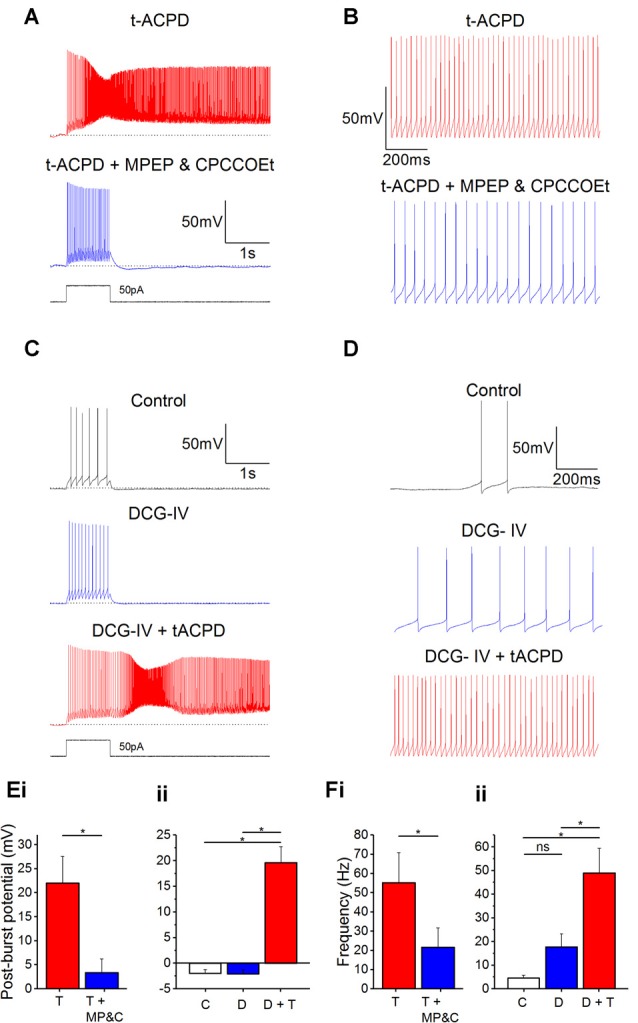
Plateau potentials are evoked by group I but not group II mGluR activation. (A) Typical response to 50 pA 1 s current pulse in the presence of 15 μM tACPD, before and after application of the mGlu5R antagonist MPEP and the mGlu1R antagonist CPCCOEt. (B) Example traces showing the decrease in spontaneous firing in the presence of t-ACPD following addition of MPEP and CPCCOEt. (C) Example traces of plateau potentials following application of the selective Group II mGluR agonist DCG-IV and DCG-IV and tACPD. (D) Example traces of spontaneous firing following application of DCG-IV and DCG-IV and tACPD. (E) Summary plots of the post-pulse potential in the presence of t-ACPD following the addition of MPEP and CPCCOEt (i; n = 5) and following DCG-IV application and subsequence tACPD application (ii; n = 5). (F) Summary plots of spontaneous firing frequency in the presence of tACPD following the application of MPEP and CPCCOEt (i; n = 4), and in response to DCG-IV and following sequential application of tACPD (ii; n = 5). Error bars = SEM. *P < 0.05.